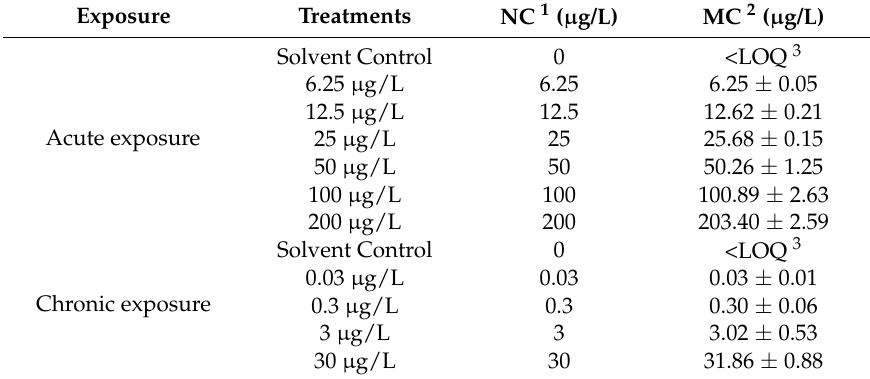
Table 1. Carbamazepine (CBZ) concentration (mean ± SD ) measured in the water of the acute and chronic exposure